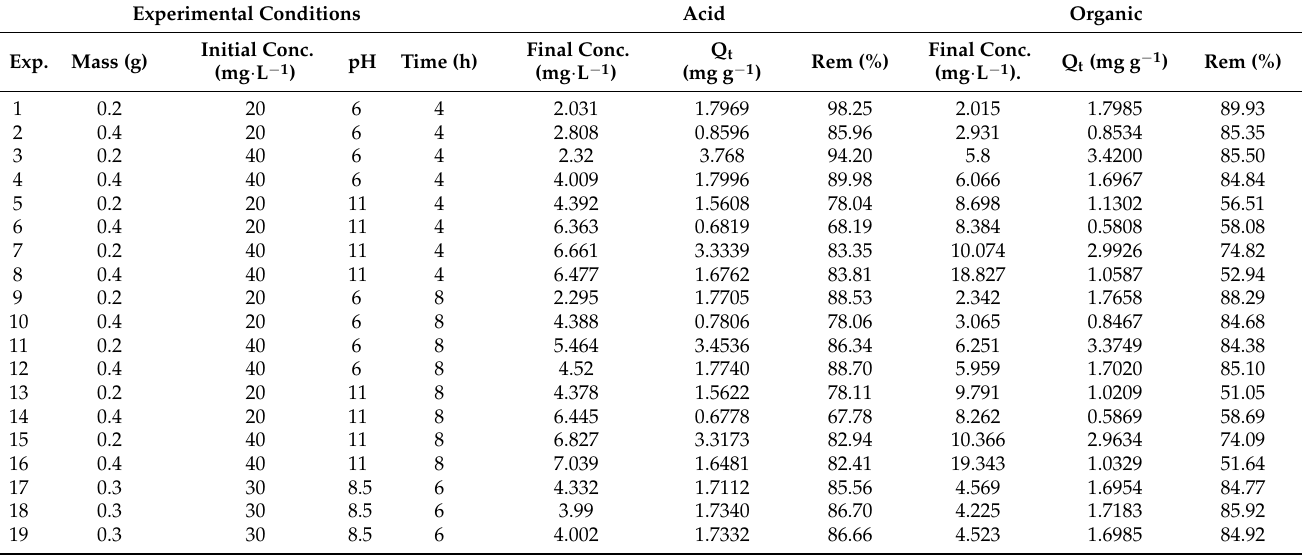
Table 4. Values of the independent variables and response variables Q t of the factorial design of the functionalized palygorskite clays. Experimental Conditions